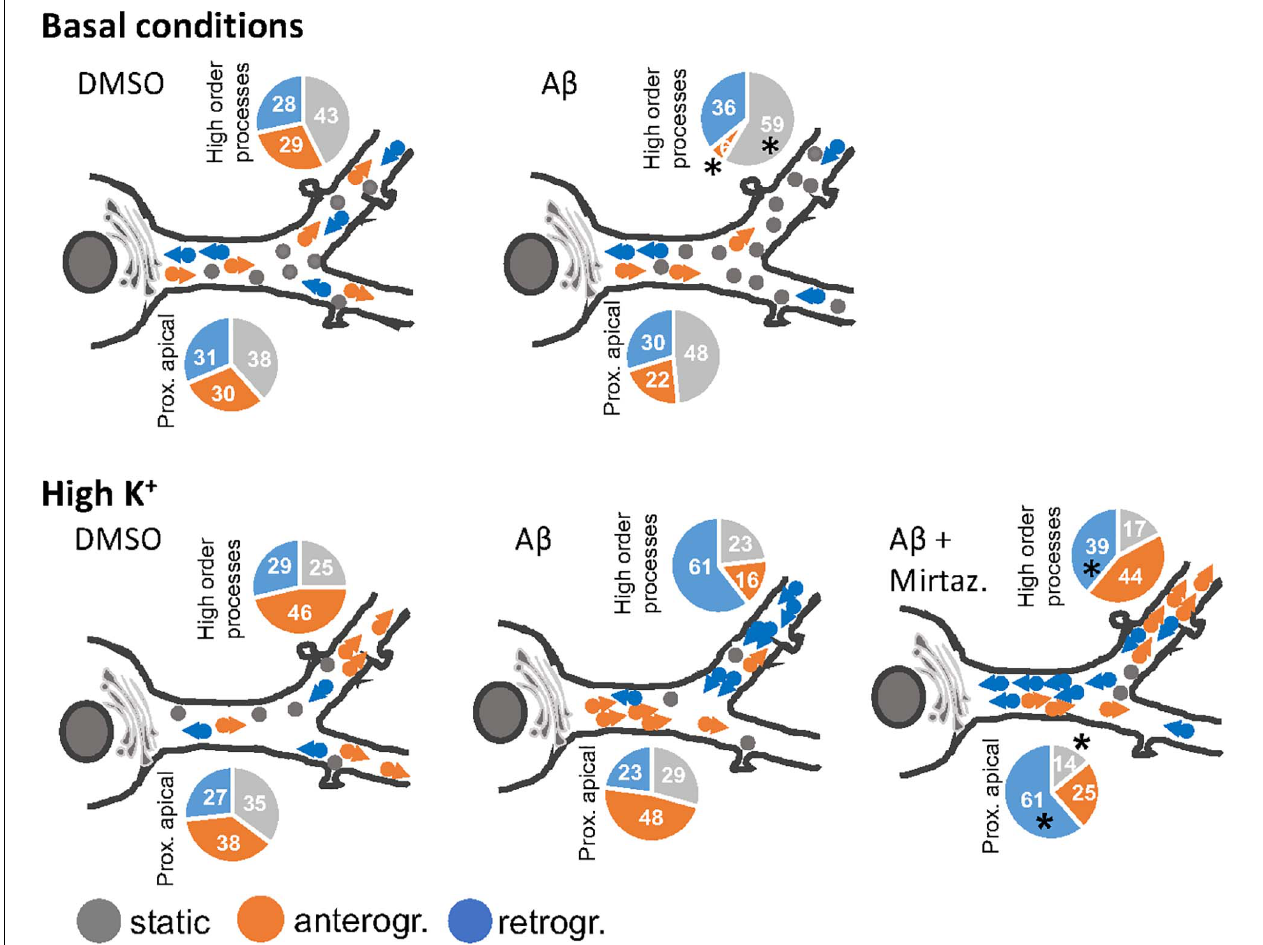
FIGURE 8 | Model of the effects of a short-term challenge with A β oligomers on the trafficking of Golgi-like spots in the apical dendrites of rat hippocampal neurons and its rescue with mirtazapine treatment (the effects on basal dendrites are omitted for simplicity). The pie charts indicate percentage of static, anterograde, or retrograde moving pGOLT spots observed in living neurons, asterisks indicate significant changes induced by mirtazapine with respect to A β .